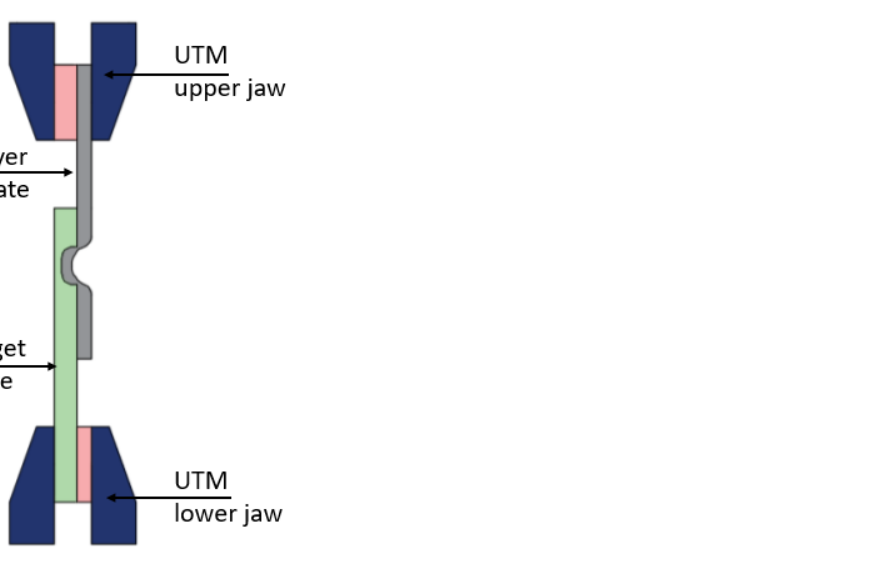
Figure 14. Arrangement for the lap ‐ shear test.